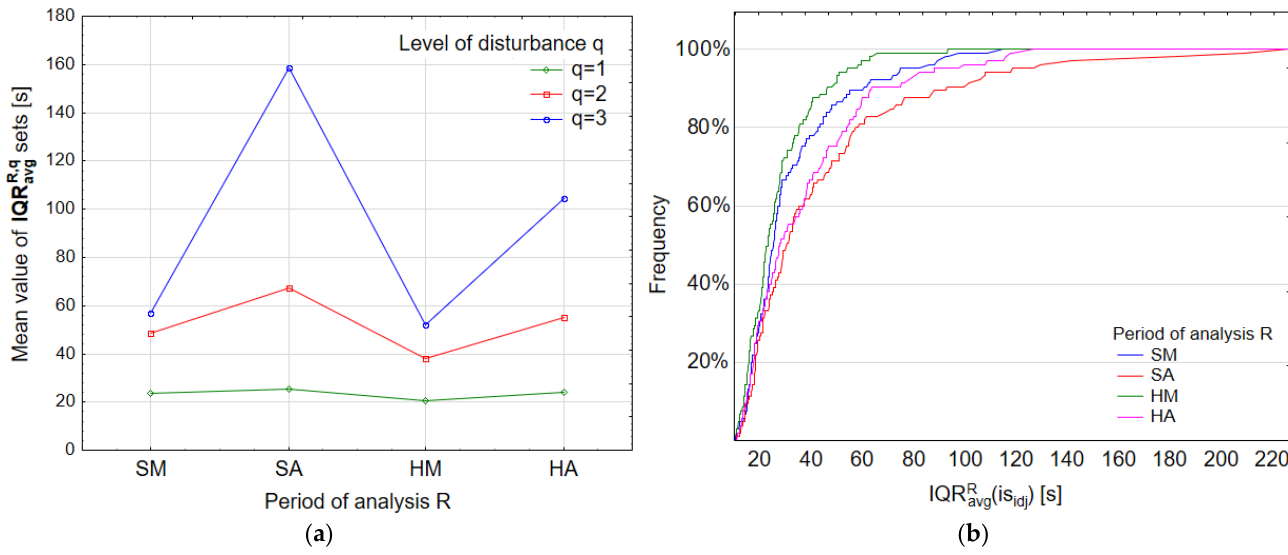
(cid:16) (cid:17) is idj values: ( a ) Means of sets IQR R , q avg